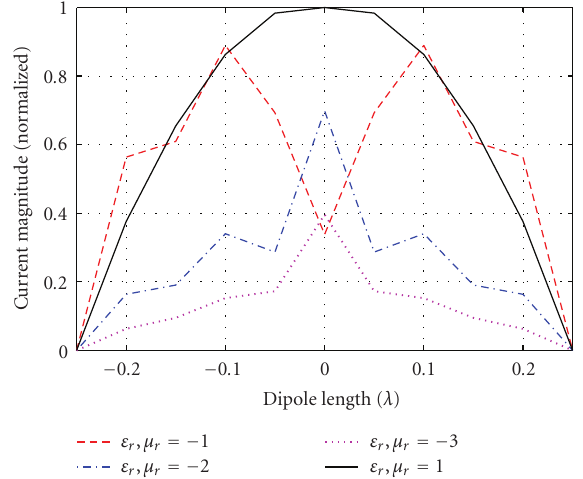
Figure 5: Current distributions at 750 MHz with ε r and μ rameters. Other parameters: L = 200 mm, a = 0 . 3175 mm, b = 1 . 8542 mm, r = 0 . 3175 mm, and N = 10.